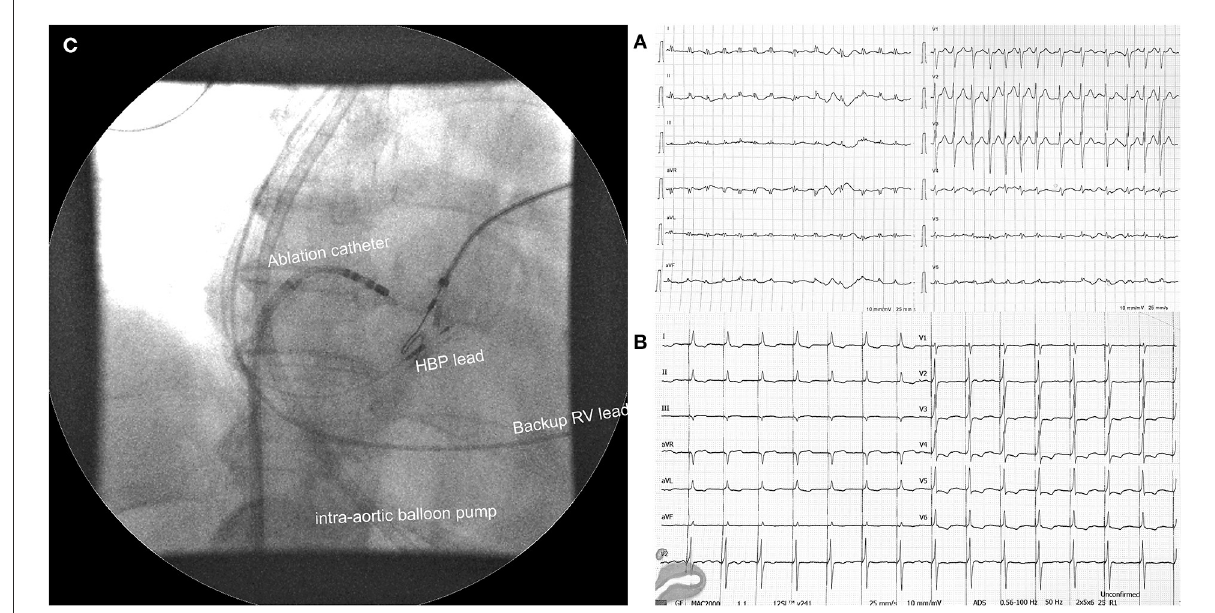
FIGURE1 (A) Electrocardiogram at admission with visible atrial fibrillation with a ventricular rate of 150 bpm. (B) Electrocardiogram after atrioventricular node ablation and His bundle pacing. (C) Position of pacing leads and ablation catheter during fluoroscopy with visible intra-aortic balloon pump in the background. HBP, His bundle pacing; RV, right